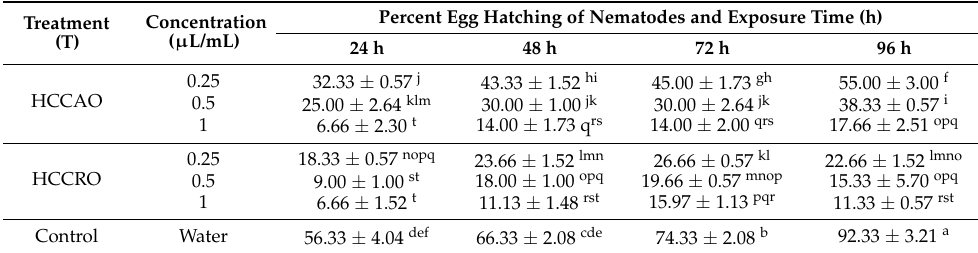
Table 4. Nematicidal activity of HCCAO and HCCRO on the egg hatching of Meloidogyne incognita . Treatment (T)